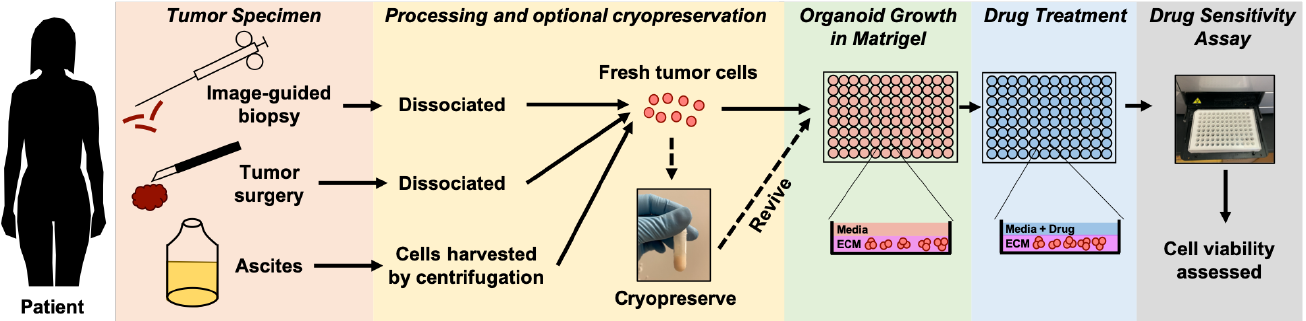
Figure 2. A workflow for testing drug response of ovarian cancer organoids using a high-throughput drug assay.